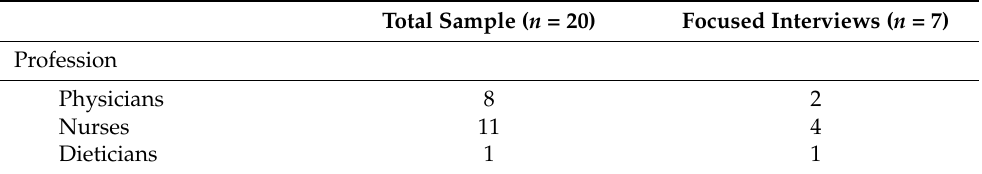
Table 2. Characteristics of the